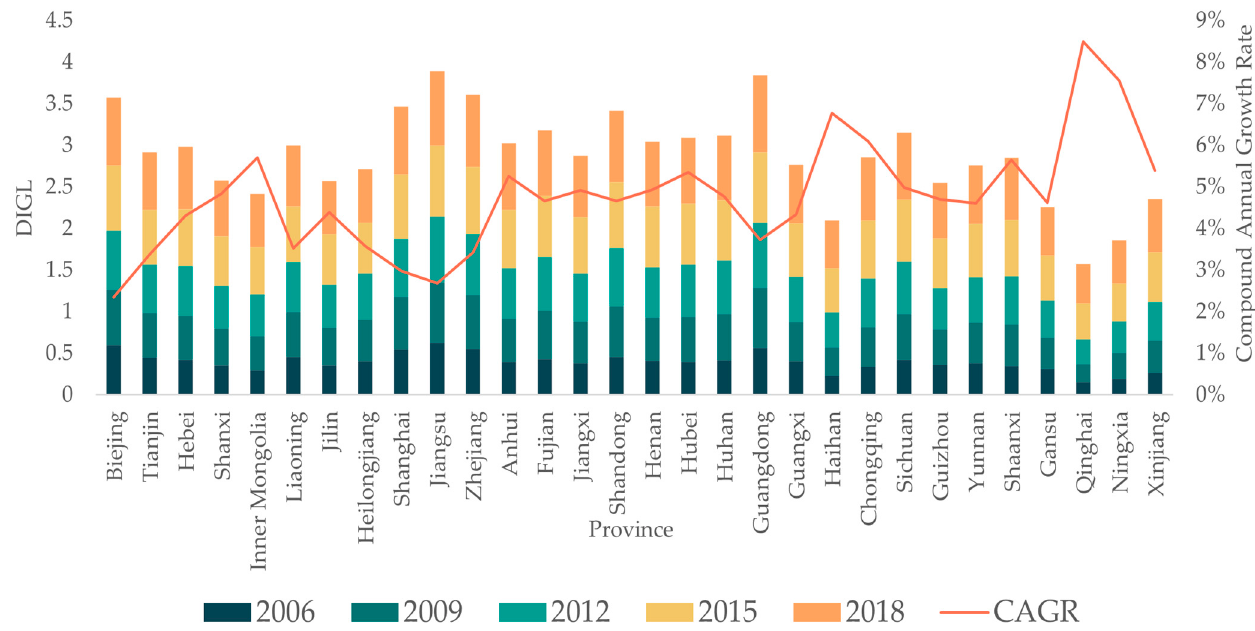
Figure 2. Temporal trends of digital development and its average annual growth rate in 30 provinces (autonomous regions and municipalities).